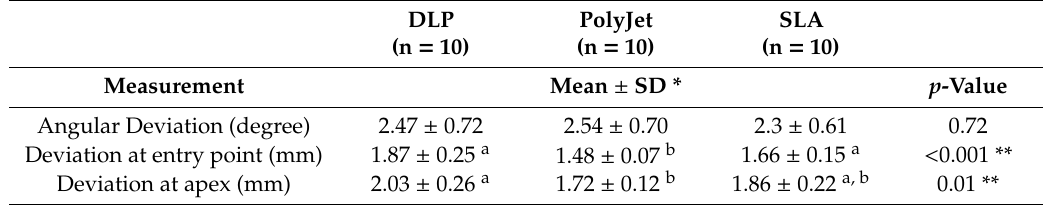
Table 2. The comparison of Mean ± SD of the 3D deviation among DLP, PolyJet, and SLA 3D printers.